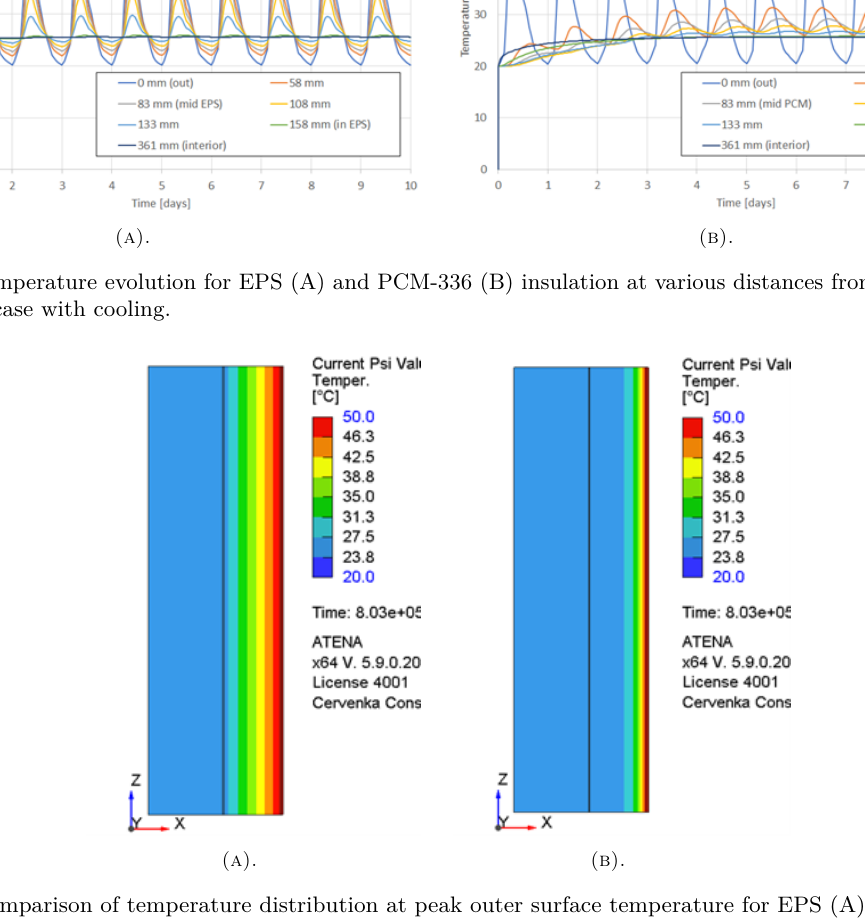
The comparison of cold temperature evolution